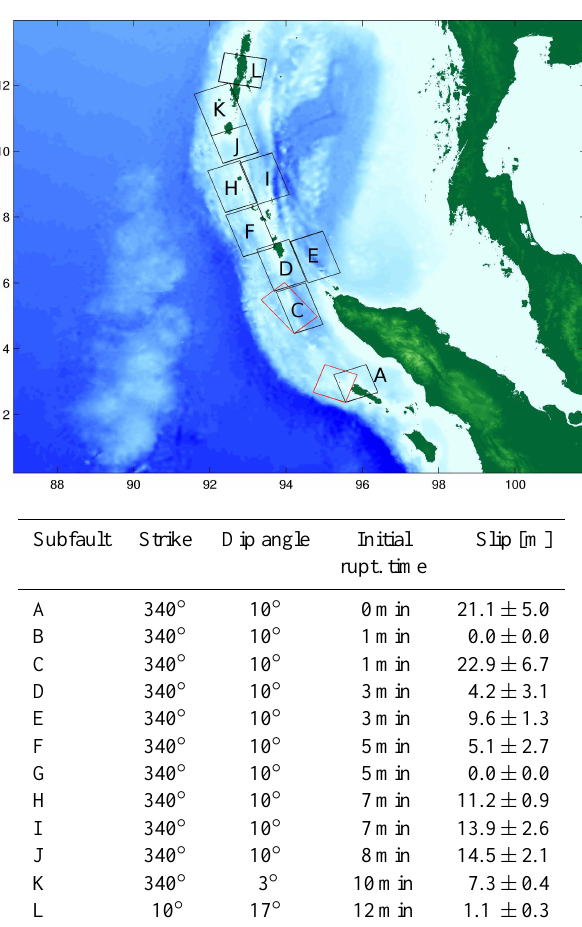
Fig. 4. Subfaults as proposed by Tanioka et al. (2006). The rup- ture area is decomposed into 12 subregions. With a rupture speed of 1.7kms − 1 , the whole rupture process takes 12min. Faults B and G have zero slip in our experiments and are not displayed. For the red faults, a different strike angle is examined.